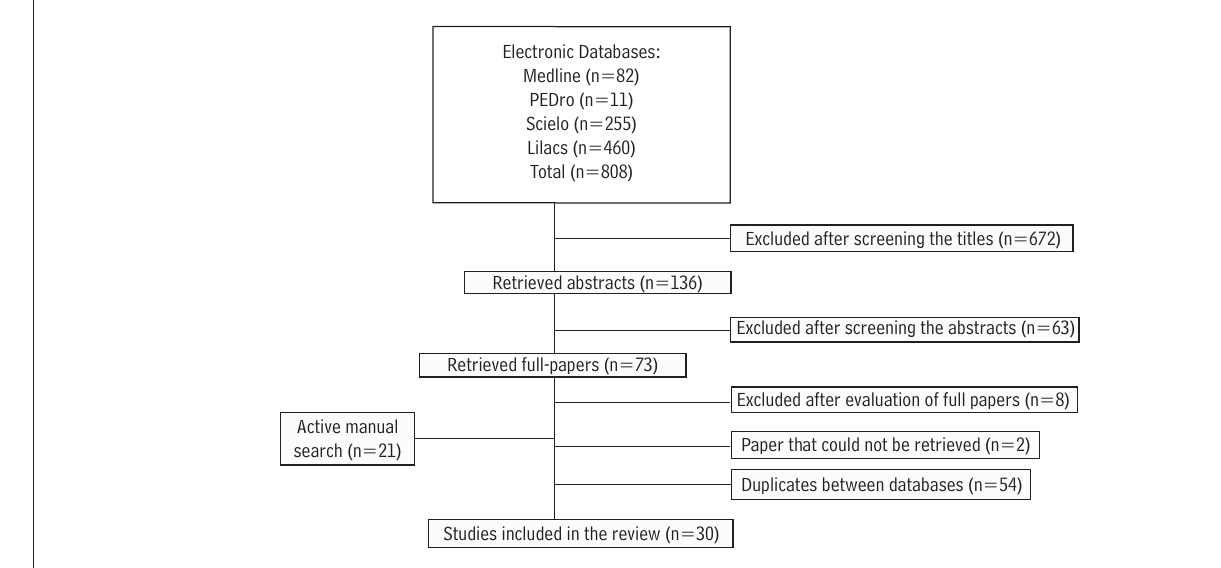
Figure 1 - Flow chart of the selection of the studies